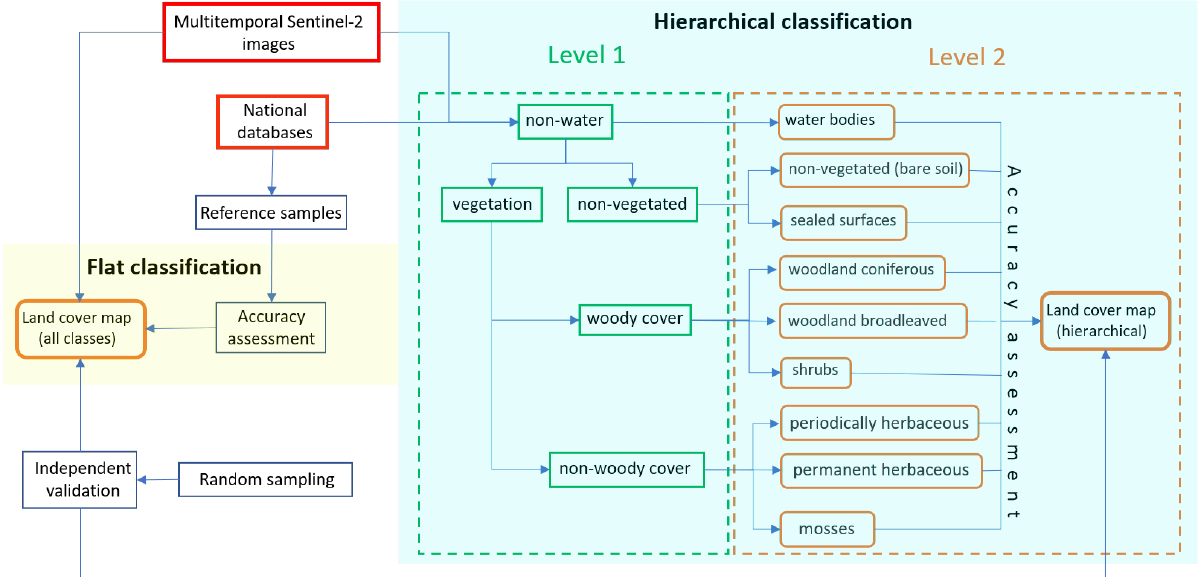
Figure 2. Flowchart of the flat and hierarchical classification of land cover using Sentinel-2 data.